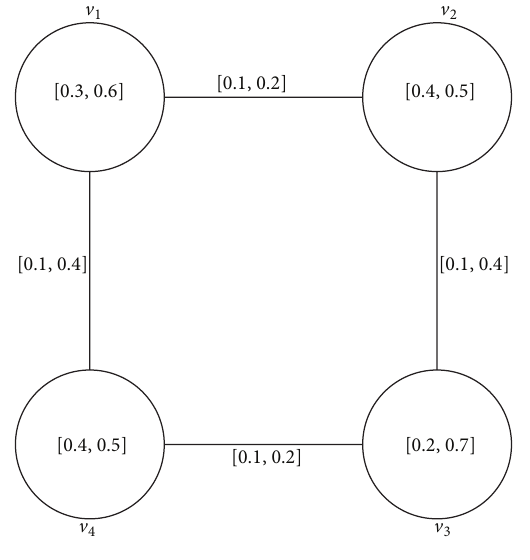
Figure 5: 𝐺 is neighbourly totally irregular.